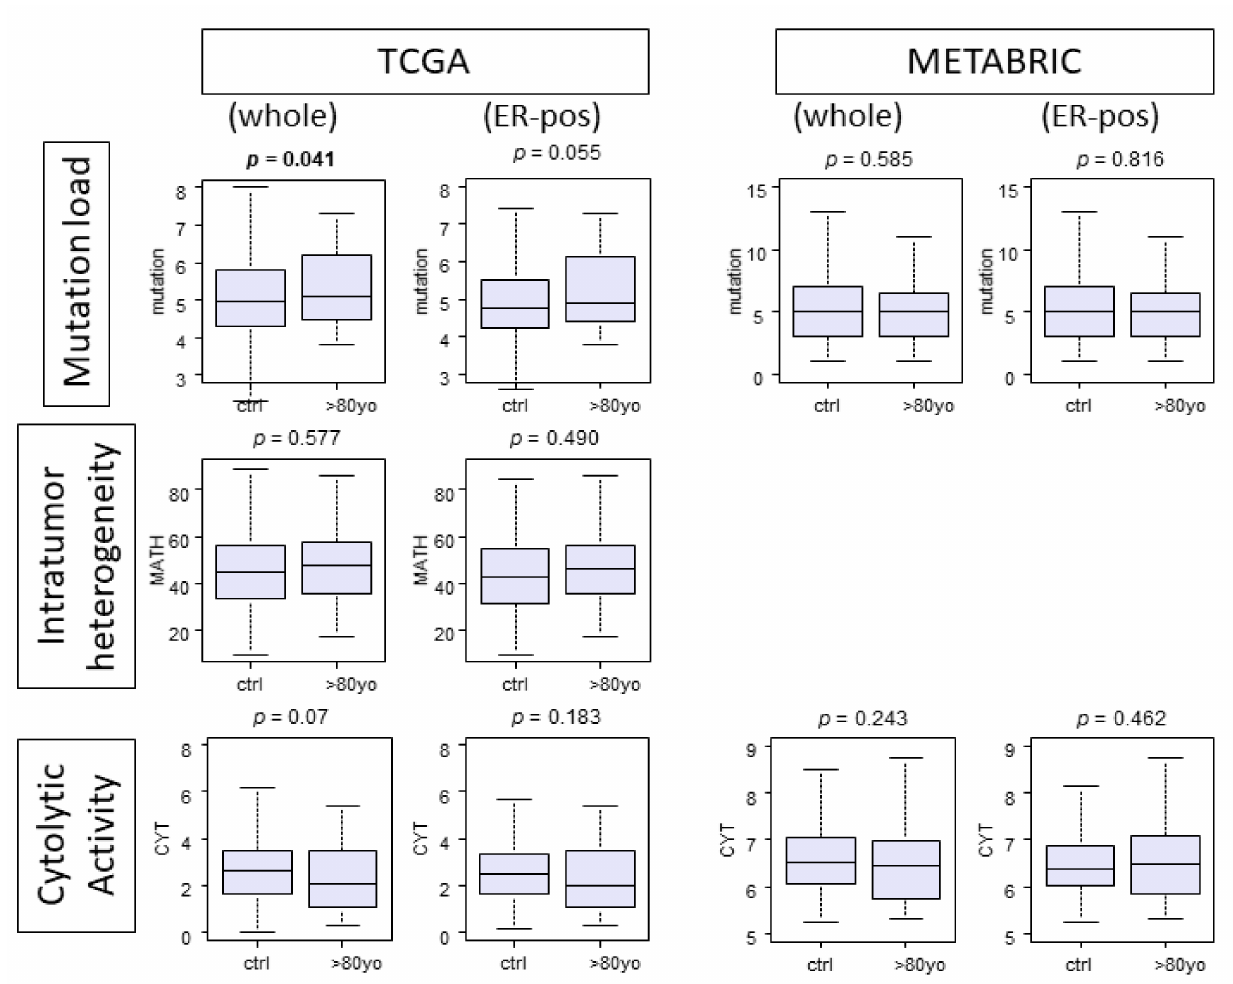
Figure 3. Boxplots comparing the control group and the octogenarians by mutation load, Mutant-Allele Tumor Heterogeneity (MATH) score, and Cytolytic Activity Score (CYT). The analysis was done with the whole cohorts and ER positive